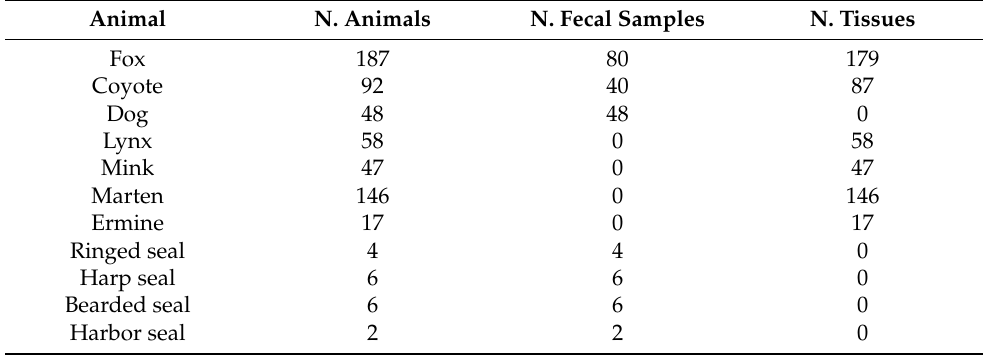
Table 1. Samples included in this study.